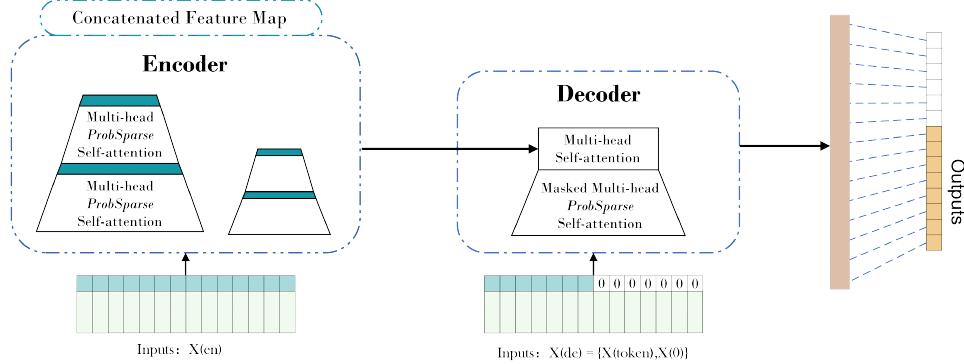
Figure 4. The overall architecture of